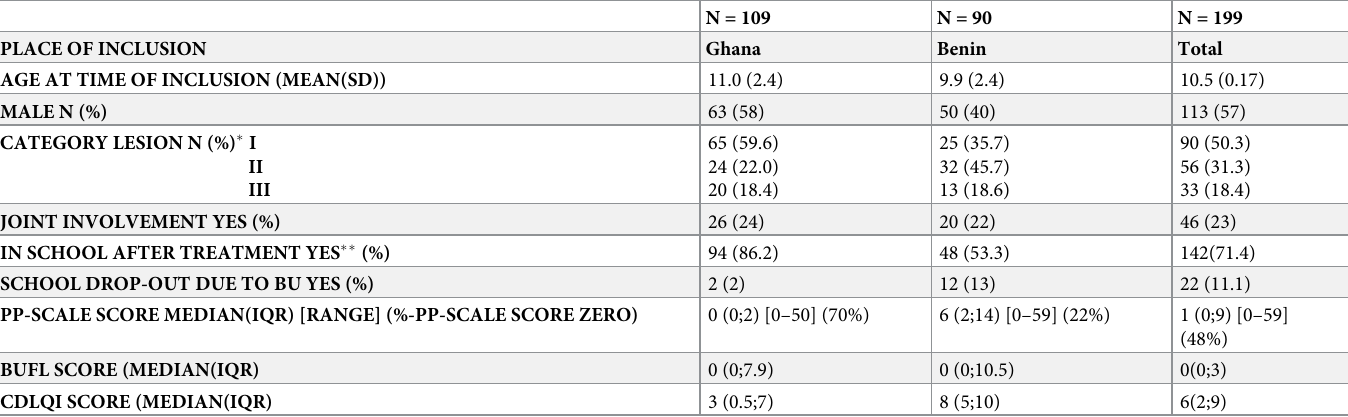
Table 1. Baseline characteristics of study population (Phase